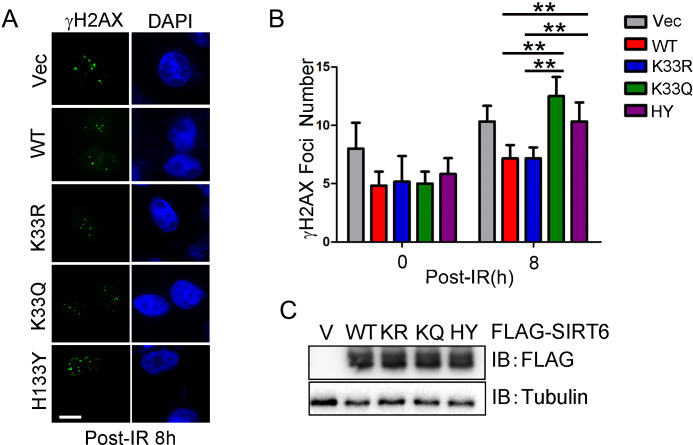
γH2AX foci in HeLa cells.(A) Immunofluorescence staining of γH2AX foci in HeLa cells expressing ectopic FLAG-SIRT6 WT, K33R, K33Q or H133Y at 8 hr after radiation. Scale bar, 10 μm. (B) Quantification of γH2AX foci-positive cells (>5 foci per cell). A total of 100 cells per sample was counted. The data represent the means ± s.e.m., **p<0.01, n = 3.